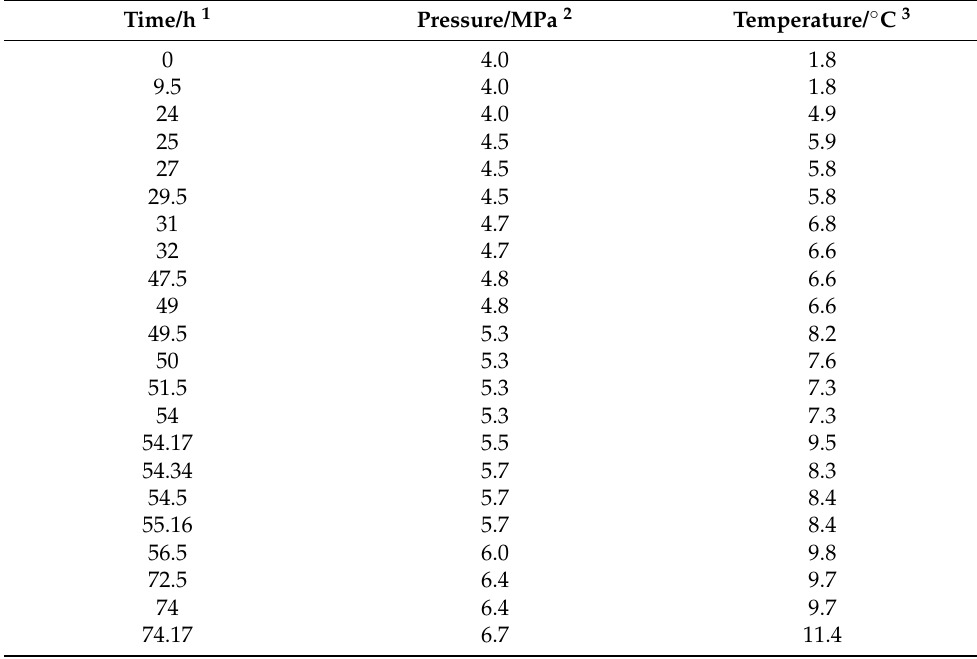
Table 1. Pressure and temperature variations during the hydrate dissociation